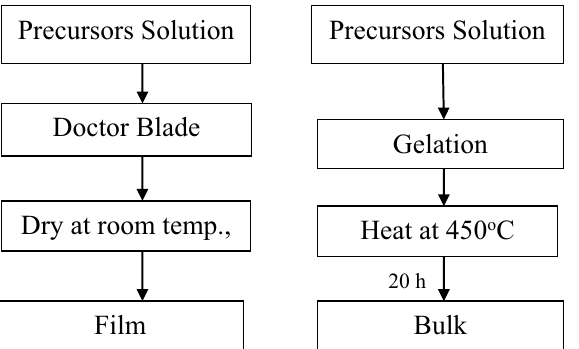
Figure 1. Flow chart for synthesize thin films and bulk samples by sol–gel